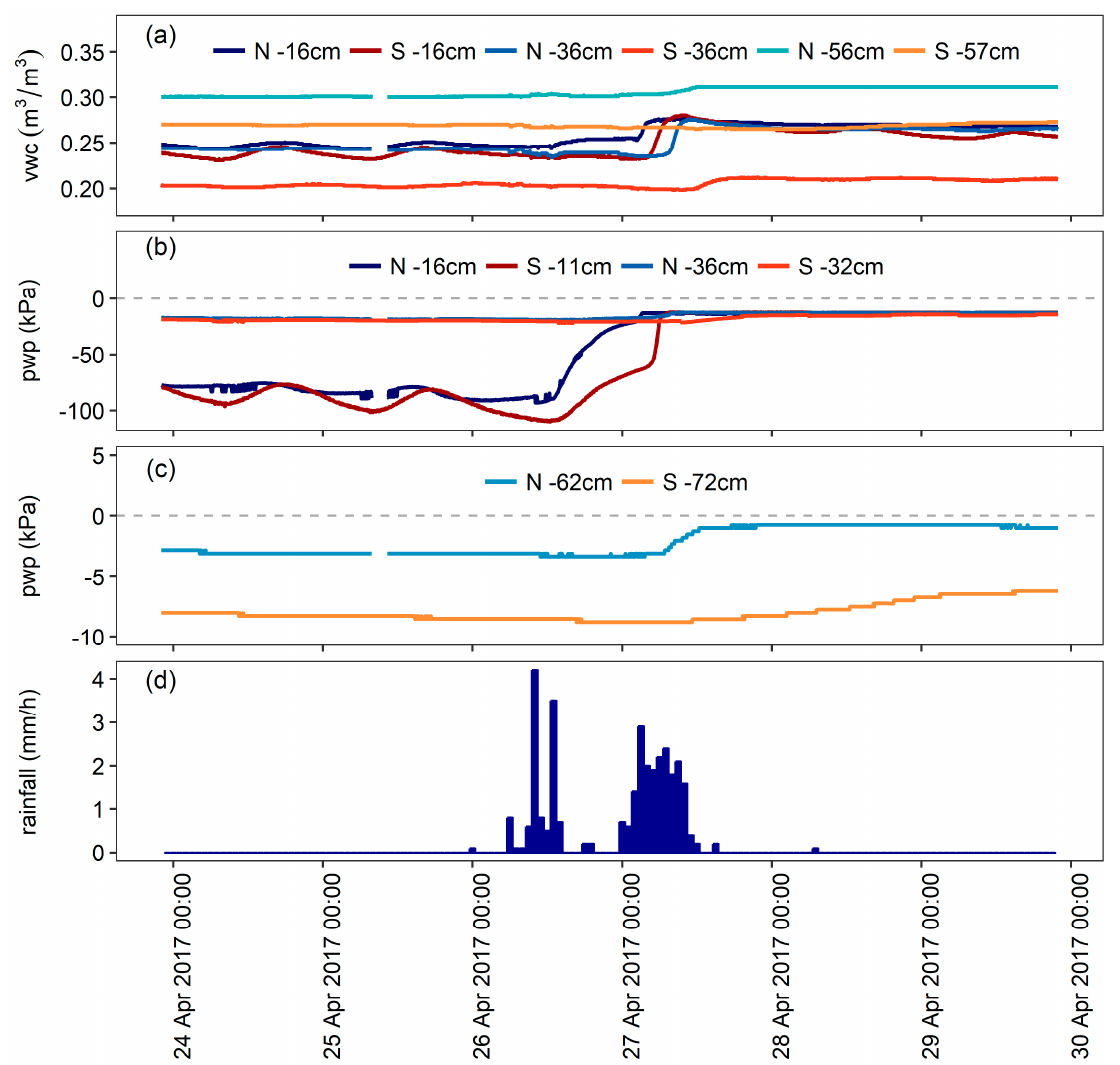
Figure 13. Soil moisture and pore water pressure registered during a rainstorm in April 2017 at the North (N) and South (S) slopes without vegetation. ( a ) Volumetric water content data measured by 5TE; ( b ) pore water pressure recorded by MPS-6 tensiometers; ( c ) pore water pressure measured by T4 tensiometers; ( d ) hourly rainfall.